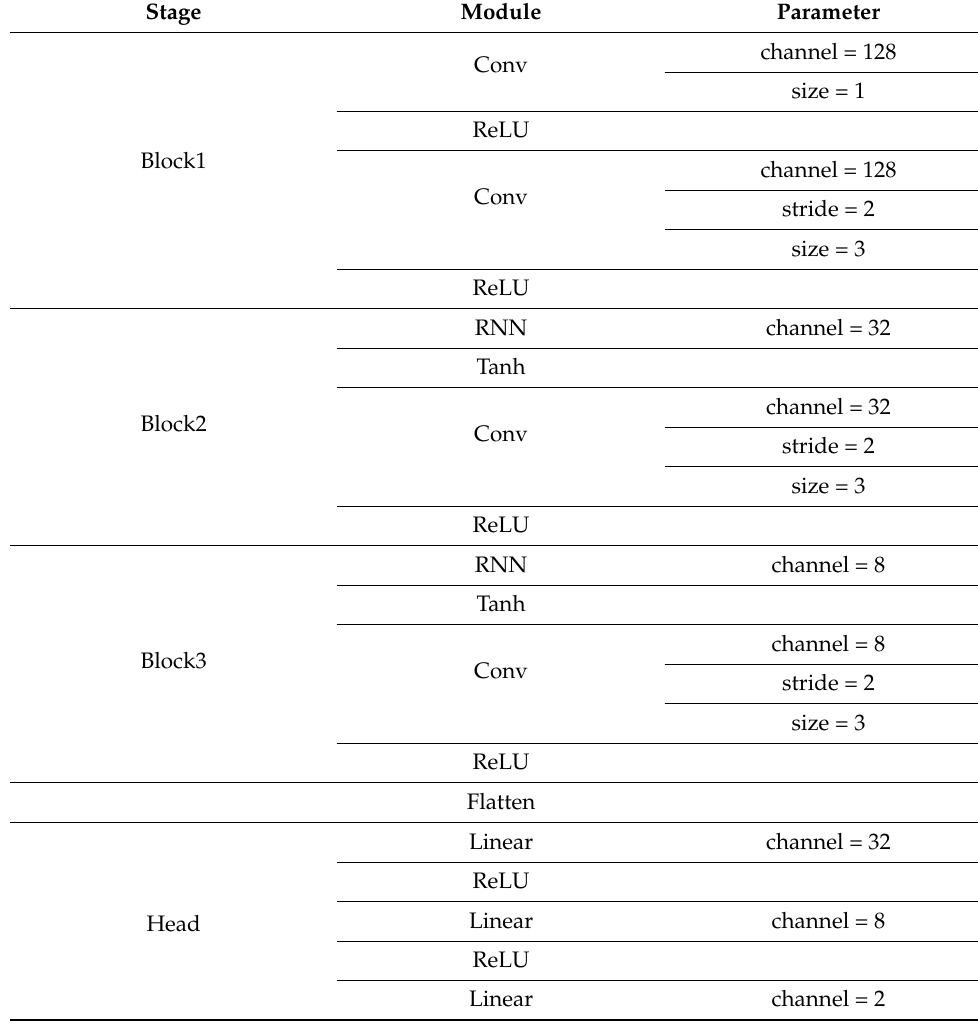
Table 1. The overall structure of the